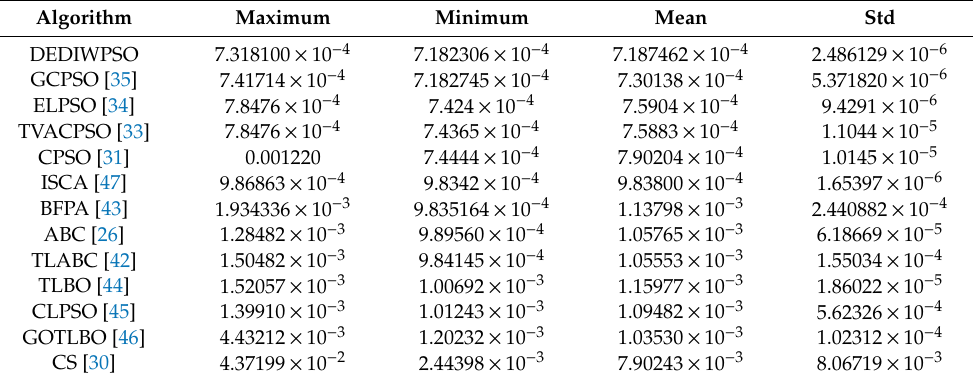
Table 5. Comparsion of the obtained RMSE for the double-diode cell.